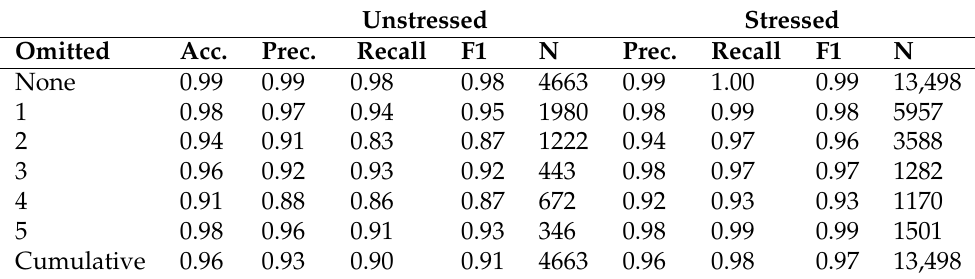
Cumulative 0.96